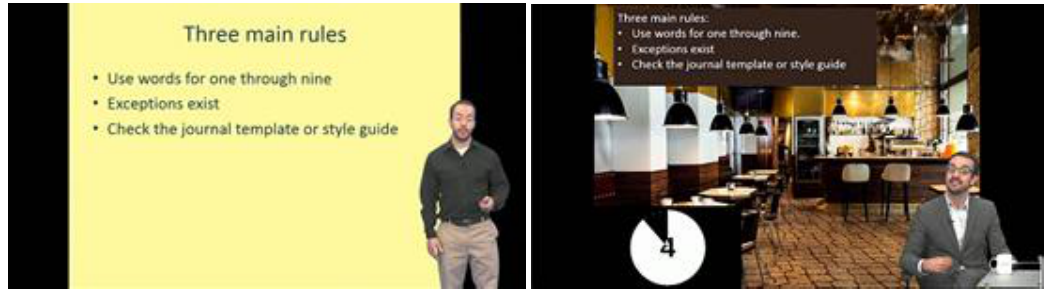
Figure 2 . (From left to right) Summaries by the main lecturer (a) and guest lecturer (b).